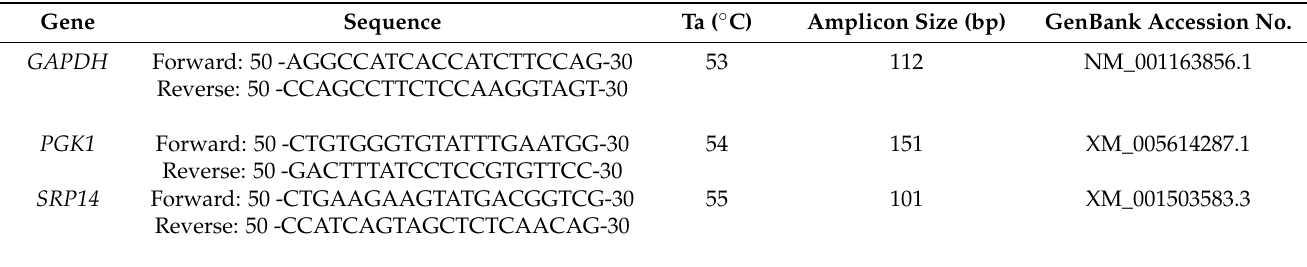
Table A1. Nucleotide sequences of primers for candidate reference (“housekeeping”) genes used for normalization of quantitative reverse transcription polymerase chain reaction